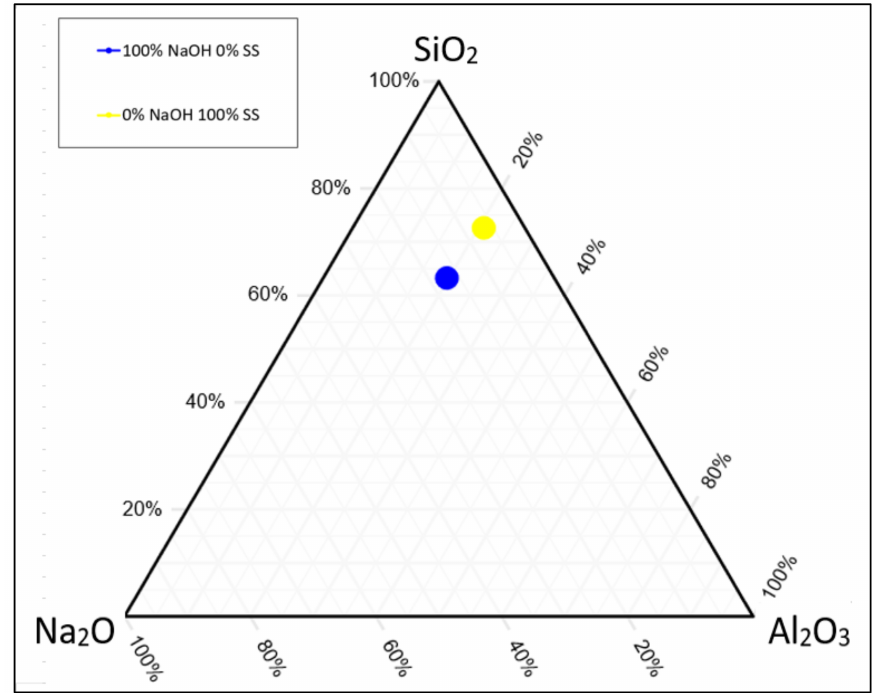
Figure 6. Ternary system SiO 2 –Na 2 O–Al 2 O 3